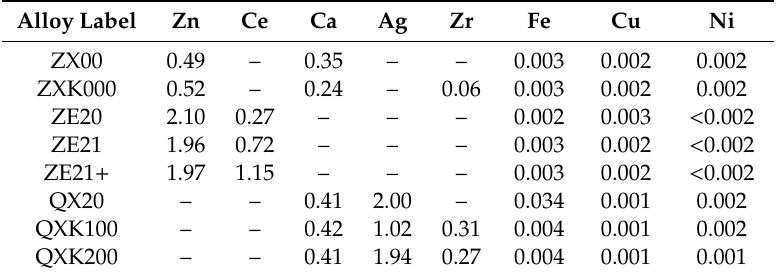
Table 1. Alloy labels and chemical compositions of the cast billets including main alloying elements and main impurity elements in wt.%, Mg